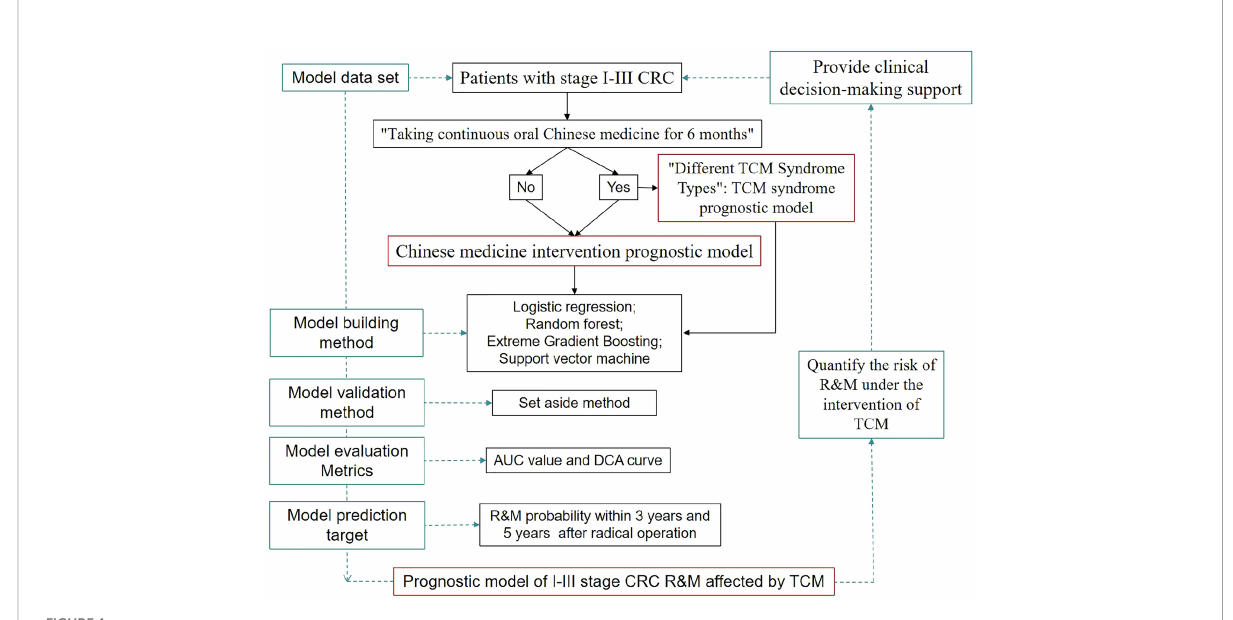
FIGURE 1 Flowchart of study pro fi